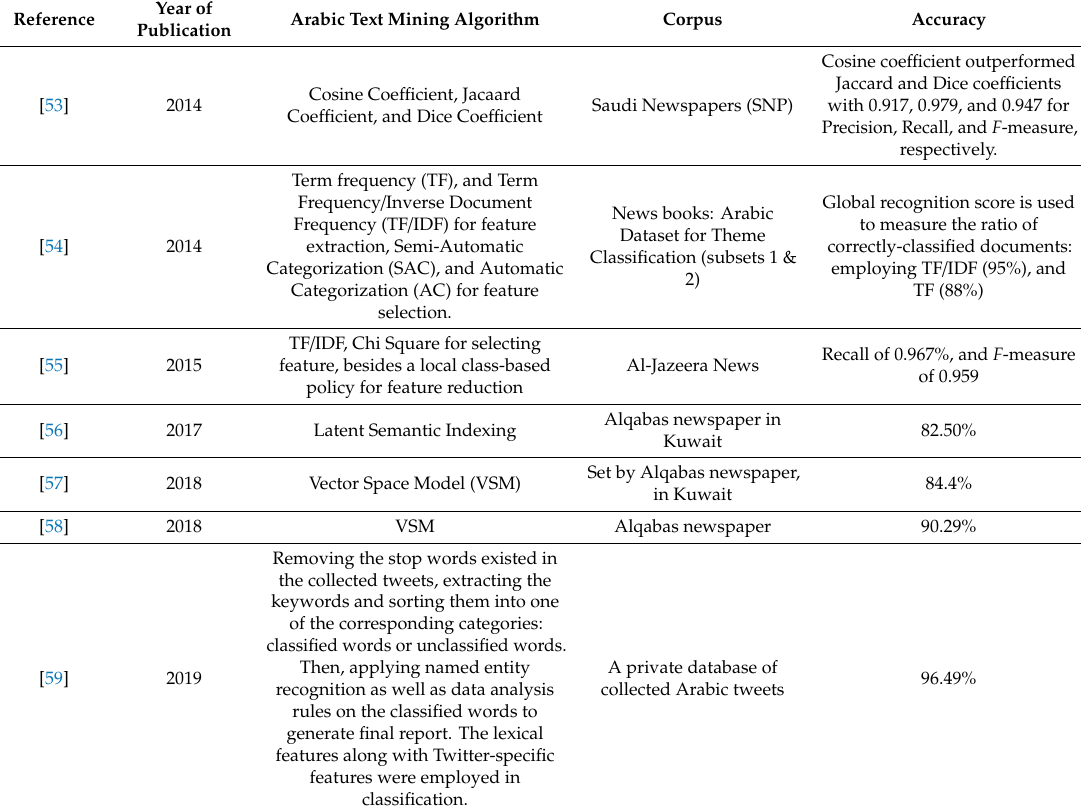
Table 1. A state-of-the-art on Arabic text